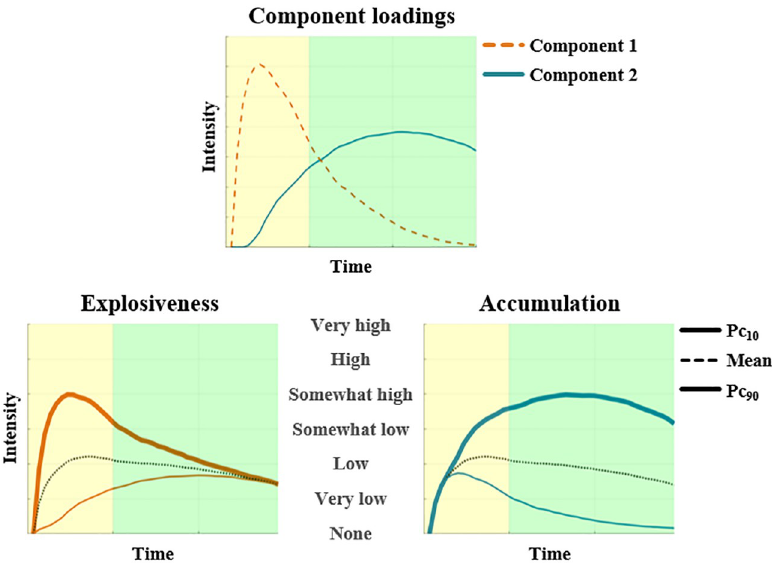
Fig 2. Two-component solution resulting from NNMF. Yellow (left) and green (right) backgrounds correspond to reading and thinking about the feedback, respectively. Top: Component loadings of emotional intensity profiles over time. Bottom: Reconstructed profiles taking a high (90 th percentile), average, or low (10 th percentile) score on the component in question and a mean score on the other component, presented according to the order of their peaks in the temporal process. This figure is based on data obtained in both self-immersed and self-distanced trials. Bottom left panel: High and low scoring profiles show an explosive and gentle start, respectively. Bottom right panel: High and low scoring profiles show emotion accumulation and recovery,